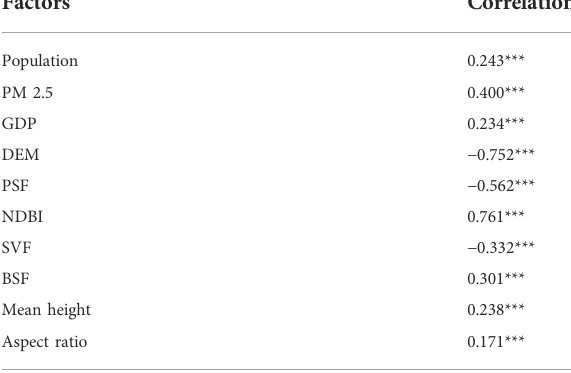
TABLE 3 Correlation analysis of LST and in fl uencing